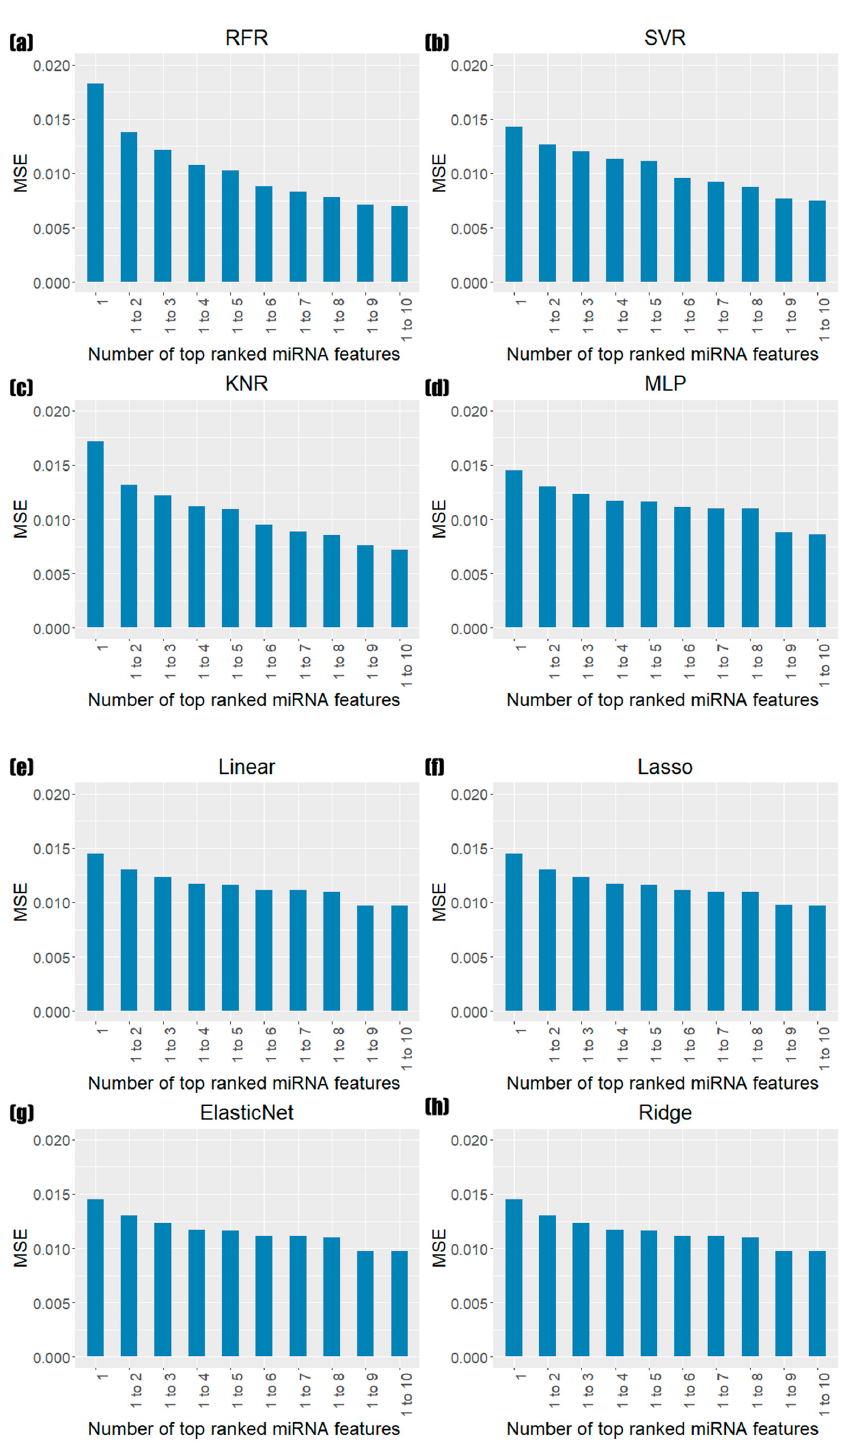
Figure 2. Bar plot test of the MSE by increasing miRNA features from the top one to the tenth using eight regression models. These are ( a ) random forest regression (RFR), ( b ) support-vector regression (SVR), ( c ) K neighbors regression (KNR), ( d ) multilayer perceptron (MLP), € linear regression (Linear), ( f ) least absolute shrinkage and selection operator (Lasso), ( g ) elastic net regression (ElasticNet), and ( h ) ridge regression